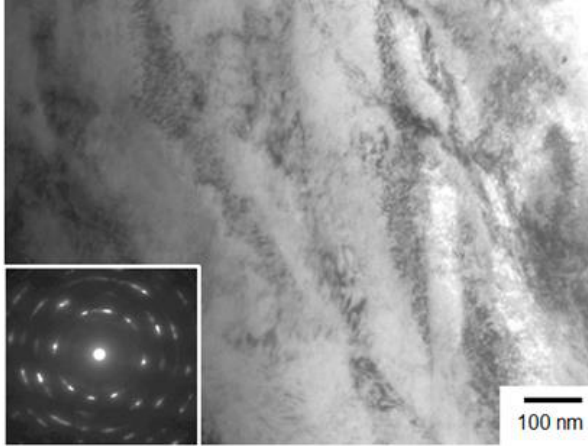
Figure 4. Transmission electron microscope (TEM) bright-filed image showing dislocation substructures in the maraging steel fabricated by selective laser melting of power bed metal, which were observed from a normal to z